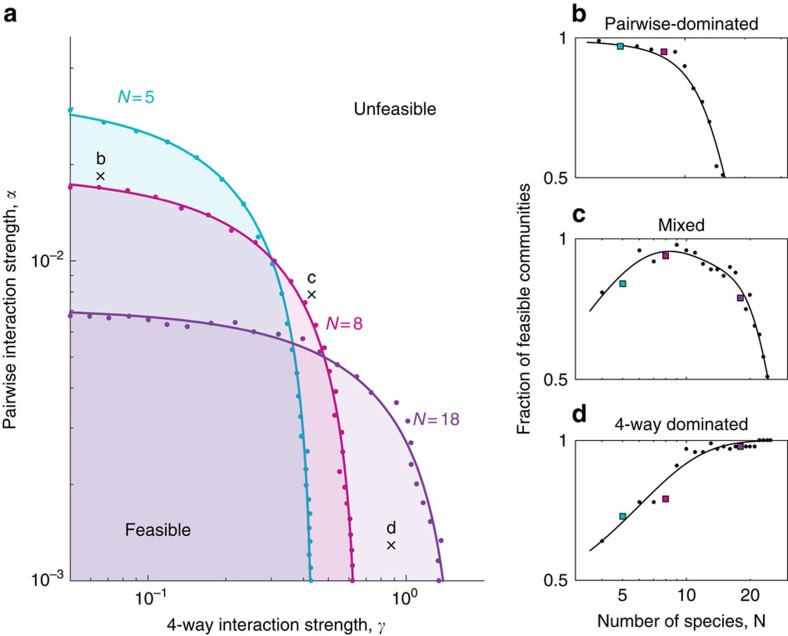
The combination of high-order and pairwise interactions determines an optimally stable range of diversities.(a) Regions of stability for 5, 8 and 18 species communities in the space of pairwise α- and four-way γ-interaction strengths (assuming no three-way interactions, β=0). Dots show the critical thresholds at which 5% of the simulations become unstable when the interaction strengths increase along radial lines in the logα-logγ space (see the ‘Methods' section). (b–d) The fraction of stable communities over the initial number of species is shown for three combinations of pairwise and four-way interaction strengths (at the points labelled by ‘x' in panel a); pairwise-dominated in b, mixed pairwise and four-way in c, and four-way dominated in d. When pairwise interactions dominate, diversity is bounded from above; when four-way interactions dominate, a lower bound on diversity appears; with both types of interactions, the level of diversity is defined to a narrow range, and within this range the community is sensitive not only to the addition but also to the removal of species.